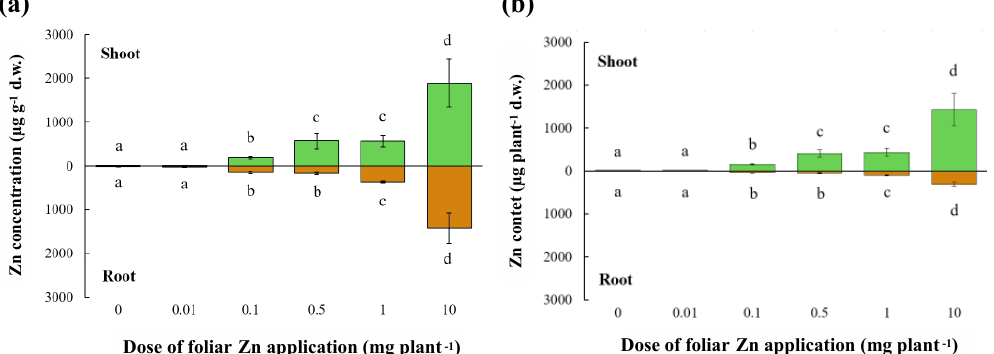
Figure 2. Zinc concentration ( a ) and content ( b ) in shoots and roots of alfalfa after the application of Zn to leaves. The Zn doses were 0, 0.01, 0.1, 0.5, 1, or 10 mg Zn plant − 1 . Means ± standard error of three replicates are shown. Differences among the applied Zn doses were tested separately for shoot and root by one-way analysis of variance. Different letters denote significant differences in Zn concentrations in shoots and roots independently, according to Tukey-B honestly test ( p < 0.05).